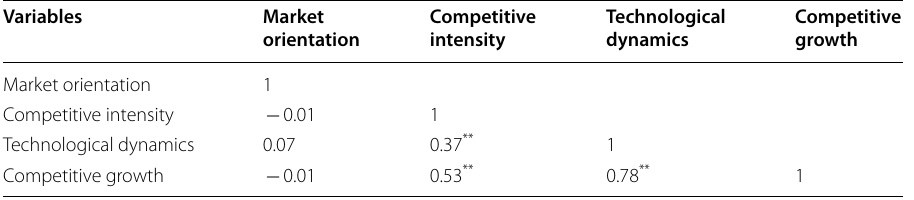
N 384, market orientation, competitive intensity, technological dynamics and competitive growth = Source: Researcher’s 2021